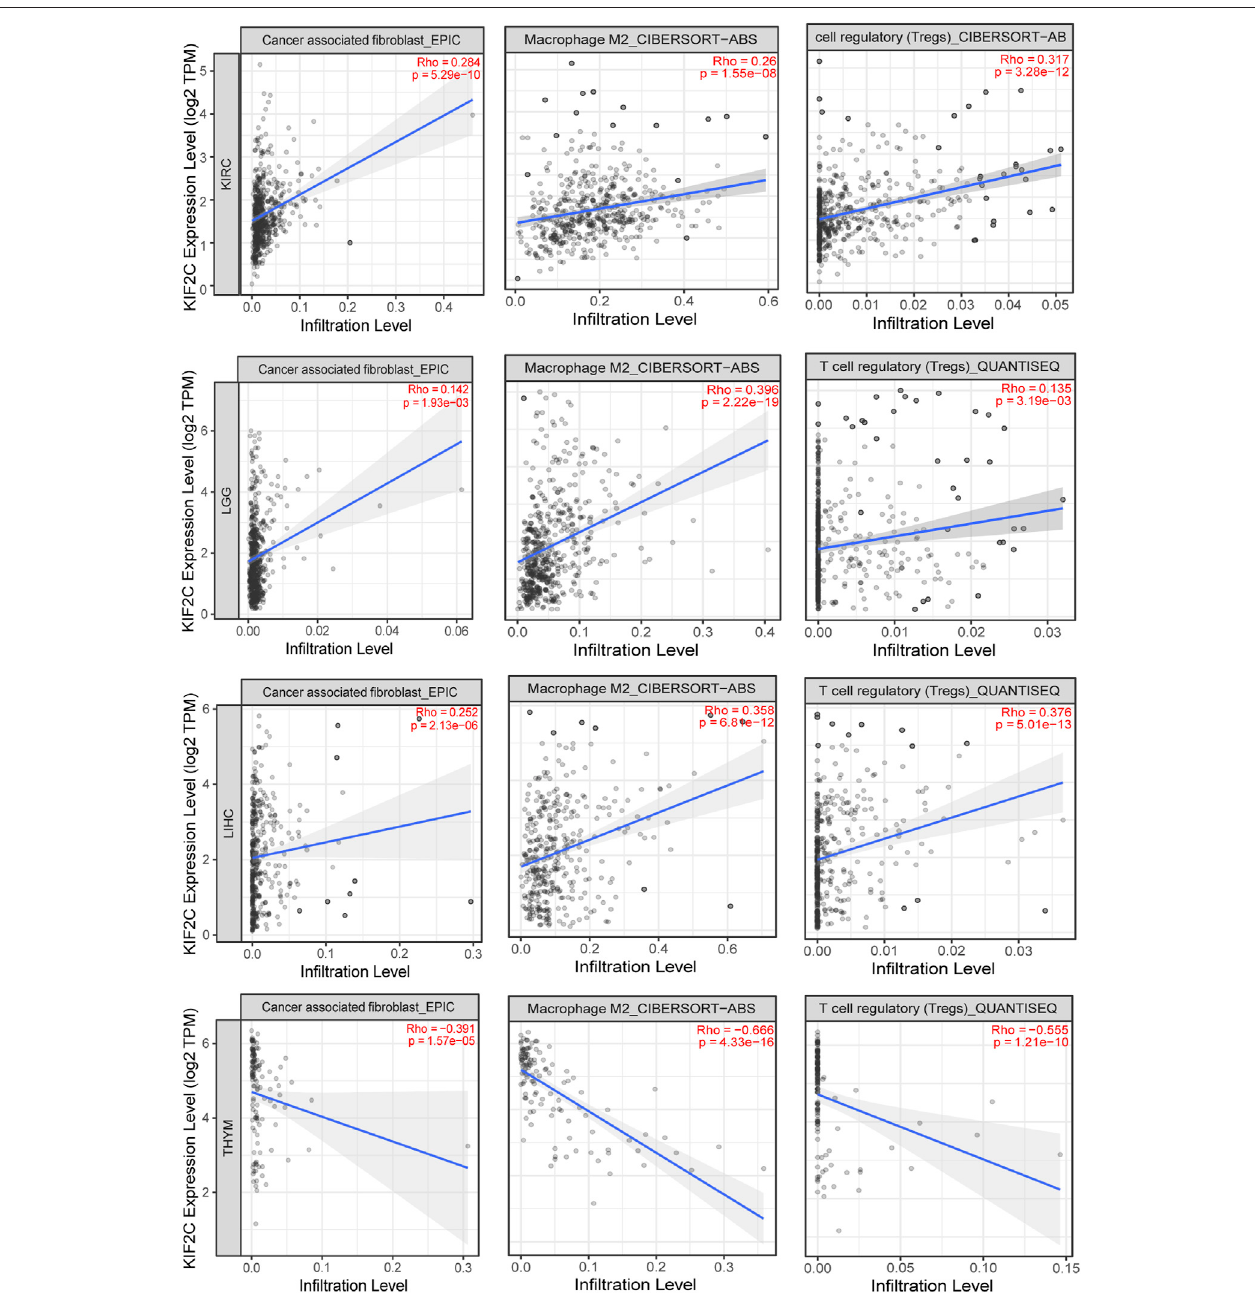
FIGURE 8 | Correlation of KIF12C expression with CAFs, M2 macrophages and Tregs in KIRC, LGG, LIHC, and THYM.